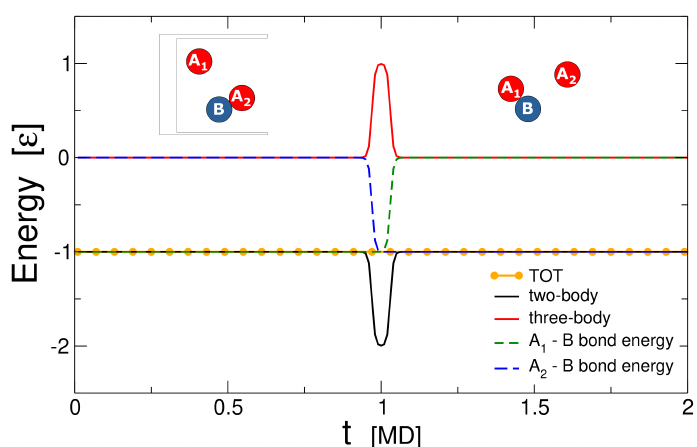
Figure 2: Time dependence of different components of the energy along a swap event at t = 1. When the particle A gets closer to B , its two-body energy decreases (blue 1 dashed line), but this change is compensated by the three-body term (red). The triplet state is short lived, in fact particle A leaves quickly after the formation of the 2 triplet. Noticeably the total energy (yellow) stays always